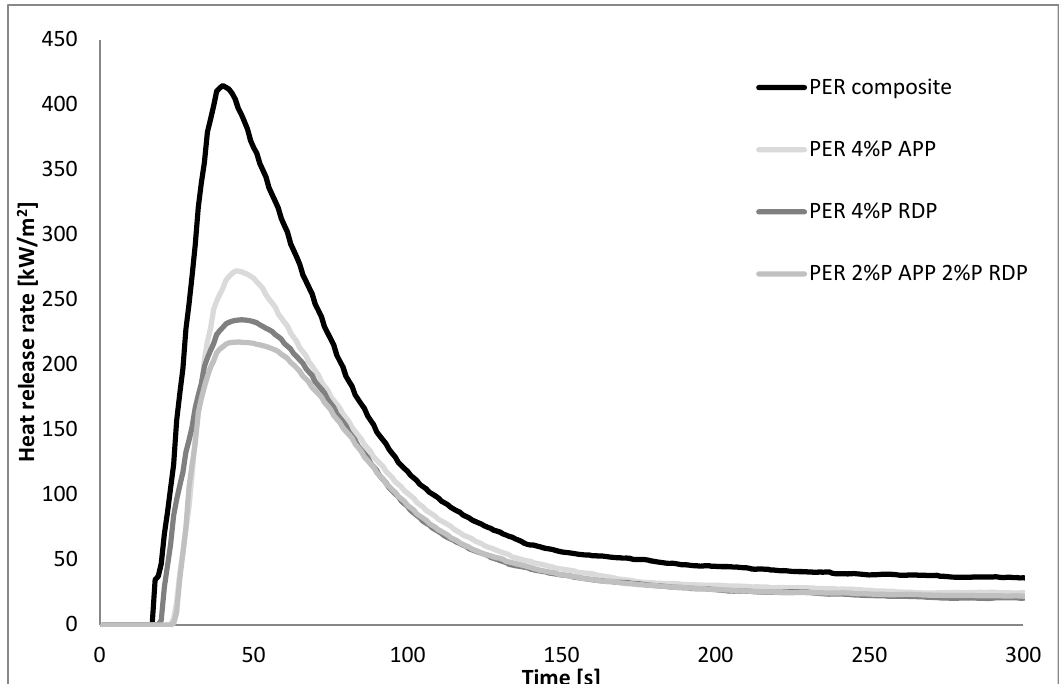
Figure 5. The heat release rate of the reference and flame retarded PER composites.